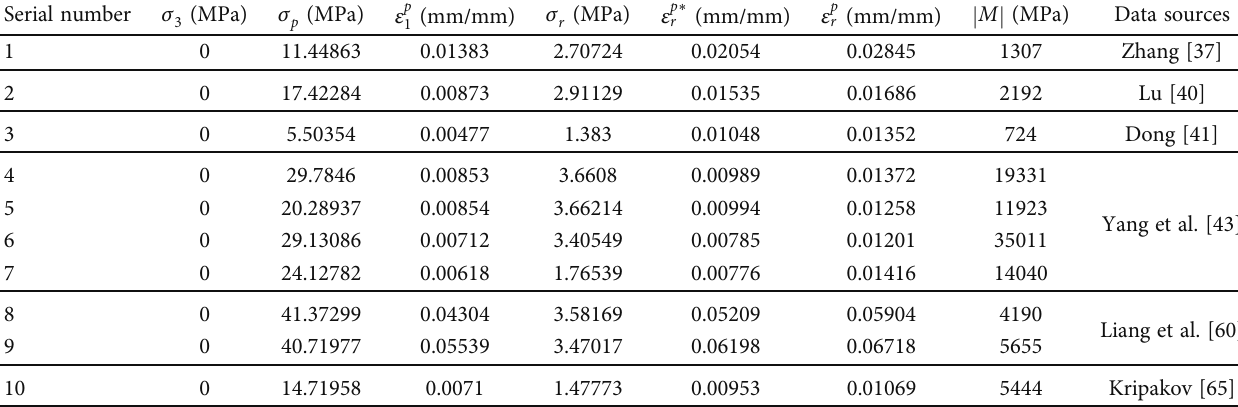
Table 2: Mechanical parameter statistics of complete stress-strain curves of raw coal during the uniaxial